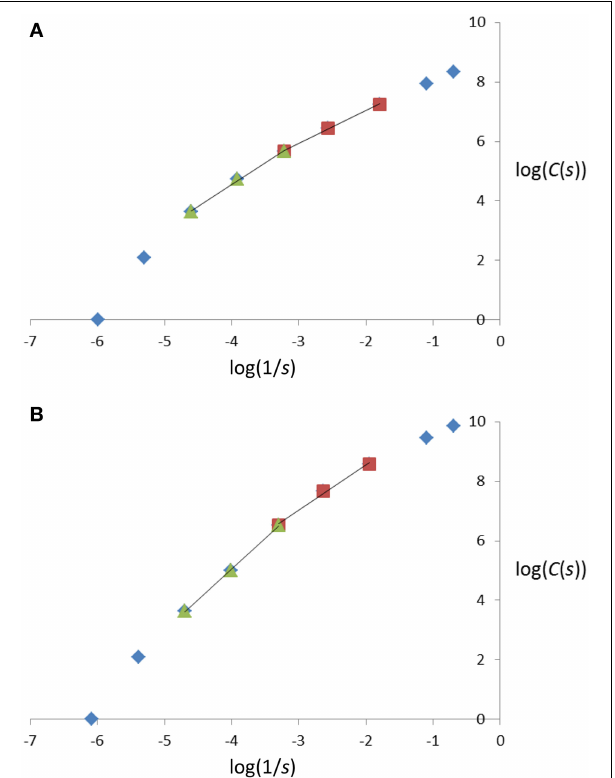
FIGURE 6 | Plot of log( C ( s )) against log(1/ s ), with s representing the cube sidelengths used in the cube-counting procedure of fractal dimension estimation, and C ( s ), the number of cubes with sidelength s , for the two miniature coniferous trees, (A) Picea abies Tompa and (B) Microbiota decussata Gold Spot, in Figures 1A, 3A and 1B, 3B, respectively. See text for details about the estimation